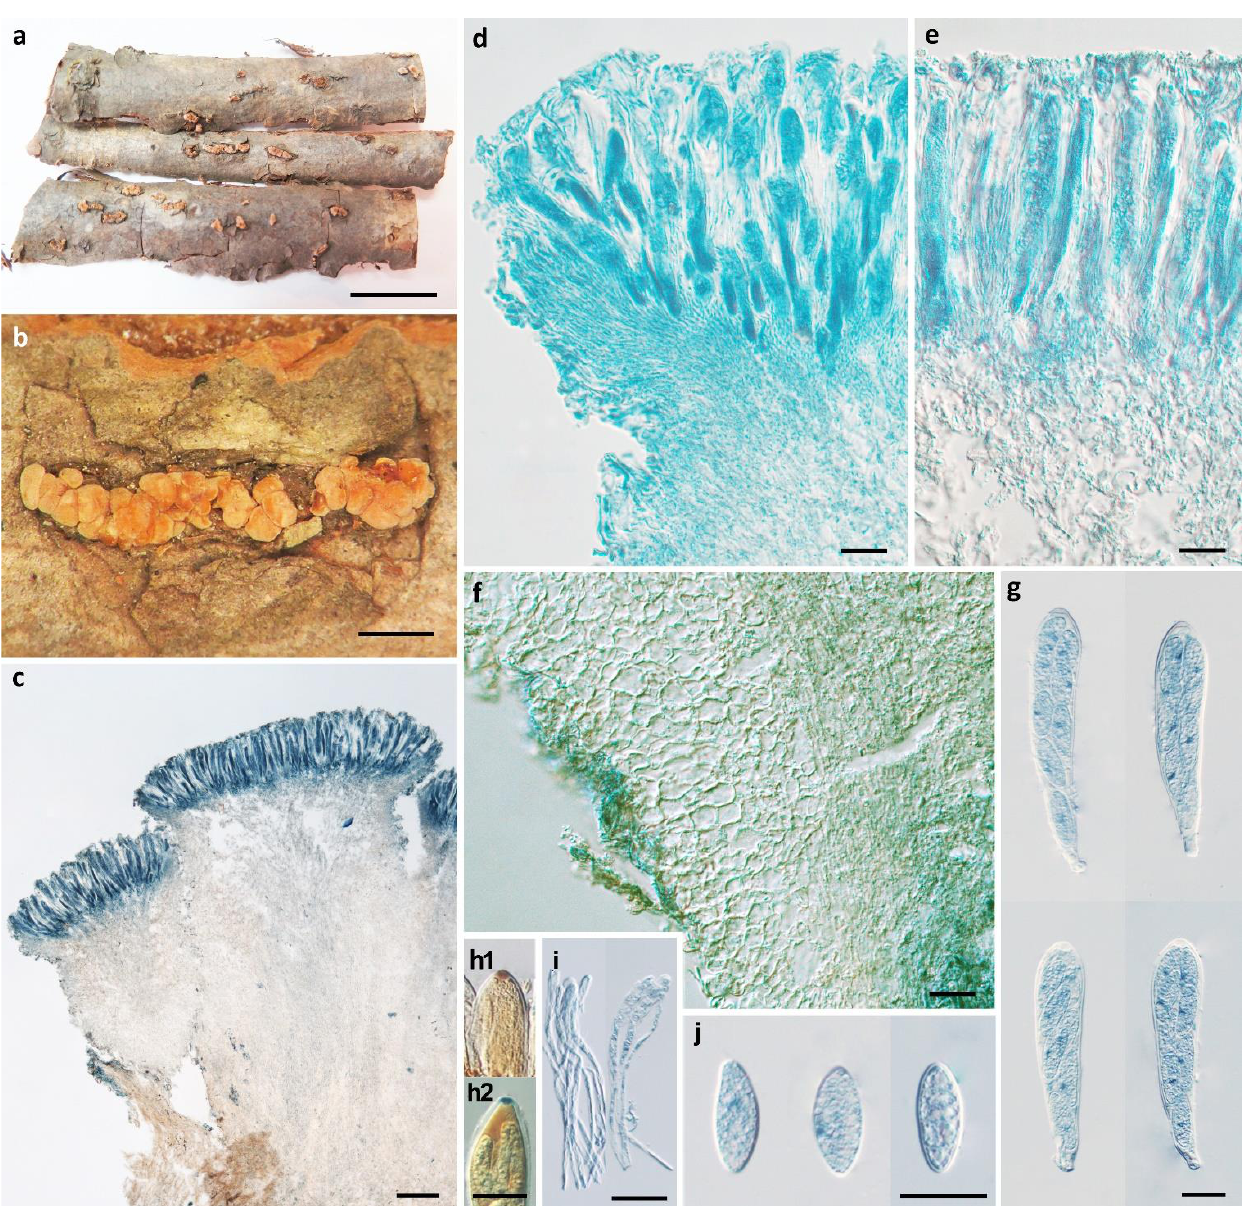
Pezicula acericola (Peck) Peck ex Sacc. & Berl., Atti Inst. Veneto Sci. Lett., ed Arti (S é r. 6) 3: 725, 1885. Figure 4.